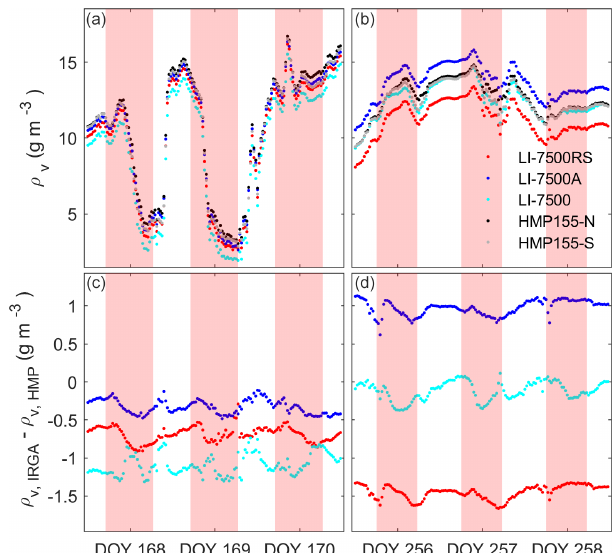
Figure 2. Absolute humidity ρ v (a, b) magnitude and (c, d) differ- ence ρ v between paired IRGA and HMP instruments (HMP155-N is paired with the LI-7500RS and LI-7500A; HMP155-S is paired with the LI-7500) during the first and last 3d of the study. Shaded areas indicate daytime.